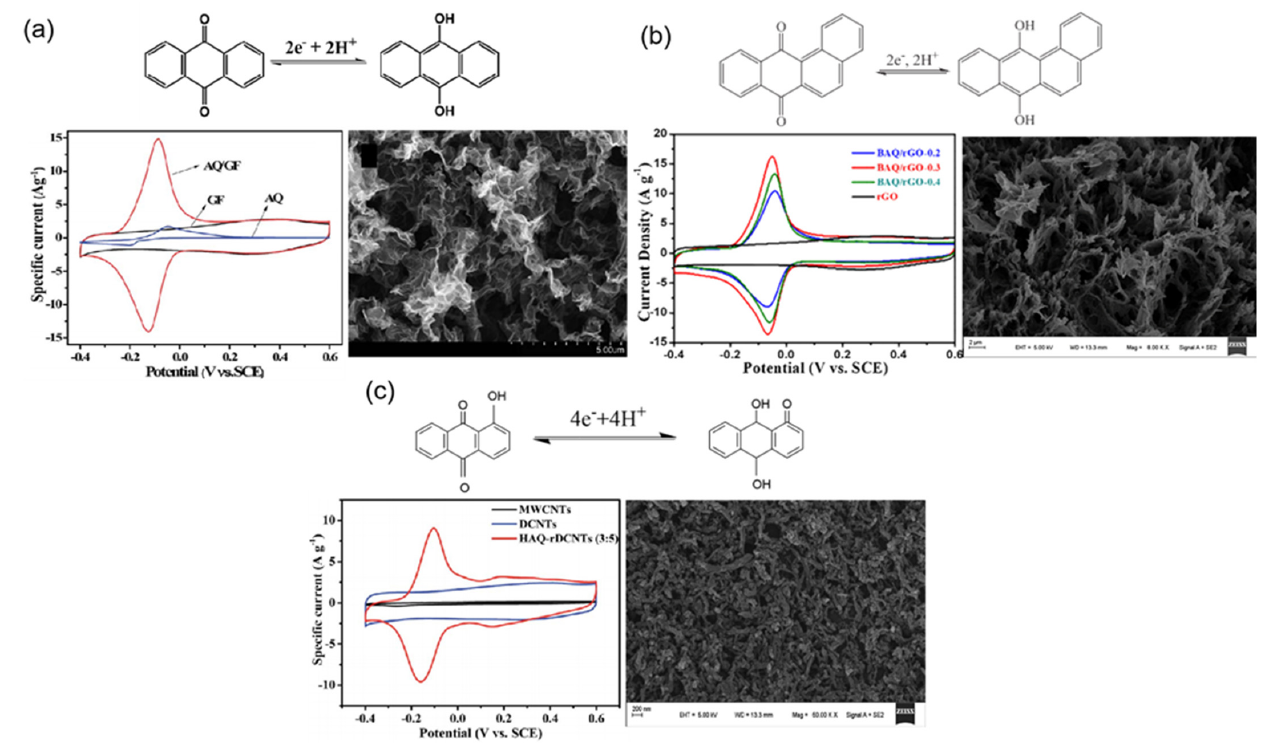
Figure 4. ( a ) The corresponding redox reactions of AQ/GF via a coupled proton–electron transfer and the CV curves of AQ, GF, and AQ/GF at a scan rate of 10 mV s − 1 and the SEM image of AQ/GF. Reproduced from [54] with permission from the Royal Society of Chemistry. ( b ) The redox of BAQ and CV curves at 10 mV s − 1 of BAQ/rGO and the SEM image of BAQ/rGO. Reprinted from [55]. Copyright (2020), with permission from Elsevier. ( c ) The electrochemical process of the conversion by four electrons and four − proton. CV curves of MWCNTs, DCNTs, and HAQ − rDCNTs and the SEM image of HAQ-rDCNTs. Reproduced from [57] with permission from the Royal Society of Chemistry.